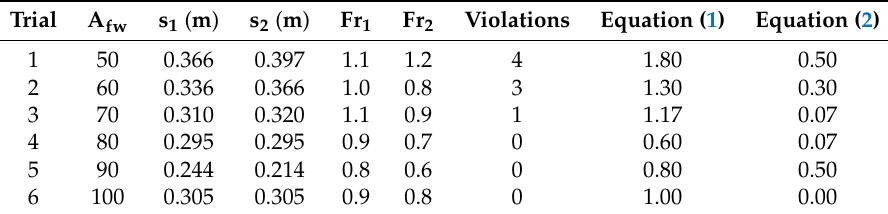
Table 1. Example model outputs and their objective function values. For all trials, N = 2, A fw,min = 50km 2 , and A fw,max = 100km 2